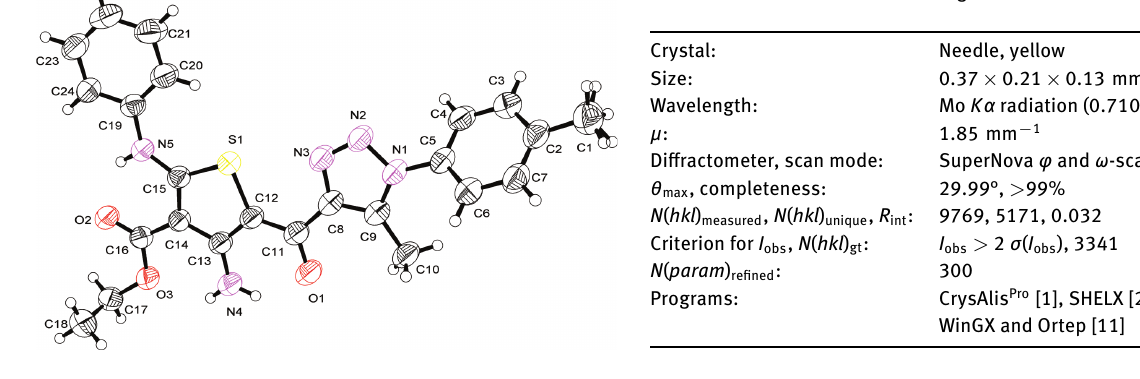
Table 1: Data collection and handling.